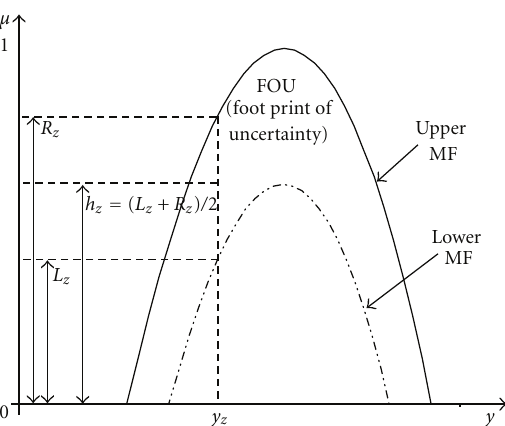
Figure 2: Diagrammatic representation of the computation of the parameters needed by each y z in Algorithm 1 for computing y t r and y t l .